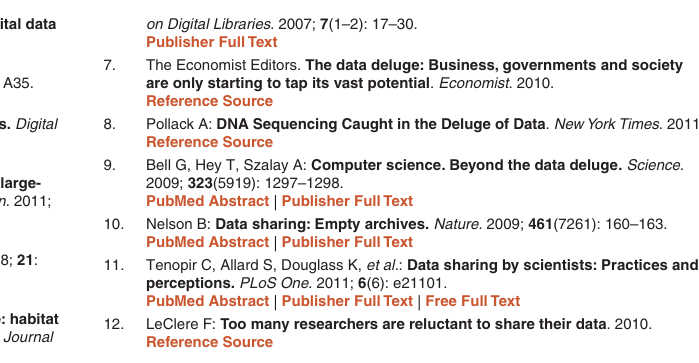
Figshare: DataUp manuscript data, doi: 10.6084/m9.figshare.884625 24 .